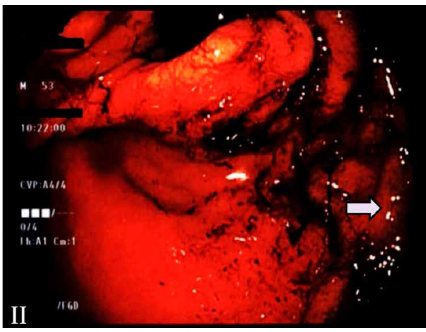
Figure 2: EGD showing retroflex view of GE junction with mass extending from lesser curvature to the cardia with clear demarcation in right lower corner (Arrow), not involving the